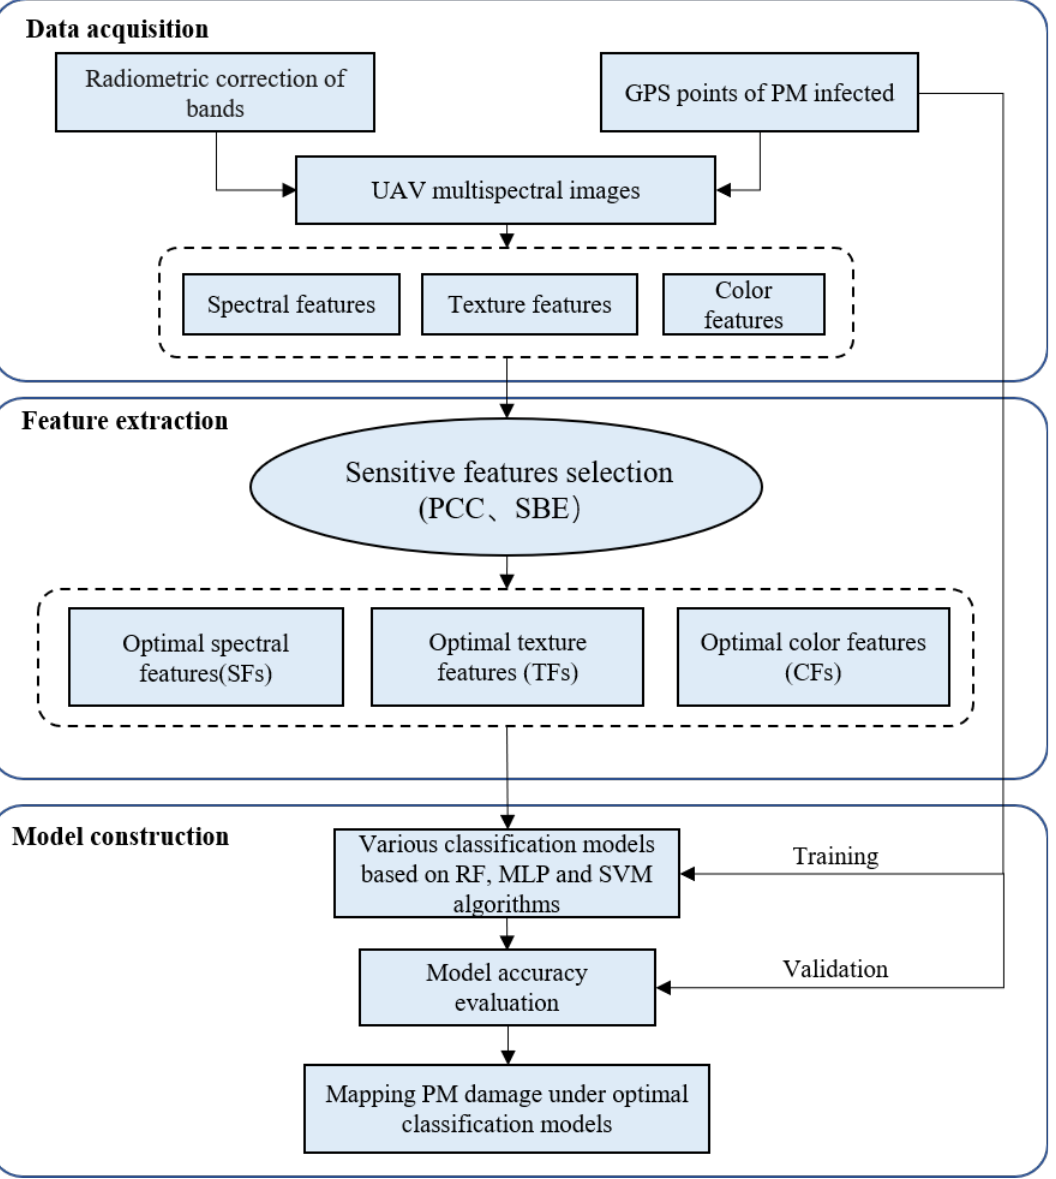
Figure 2. The framework of rubber tree powdery mildew detection based on UAV multispectral data.